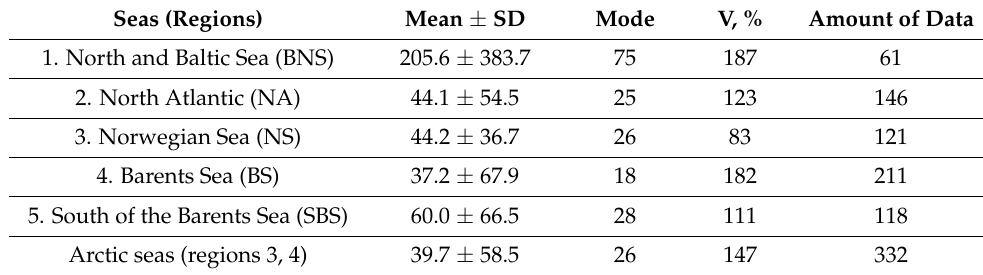
Table 3. Statistical characteristics of М ВС (ng/m 3 ) in different regions.